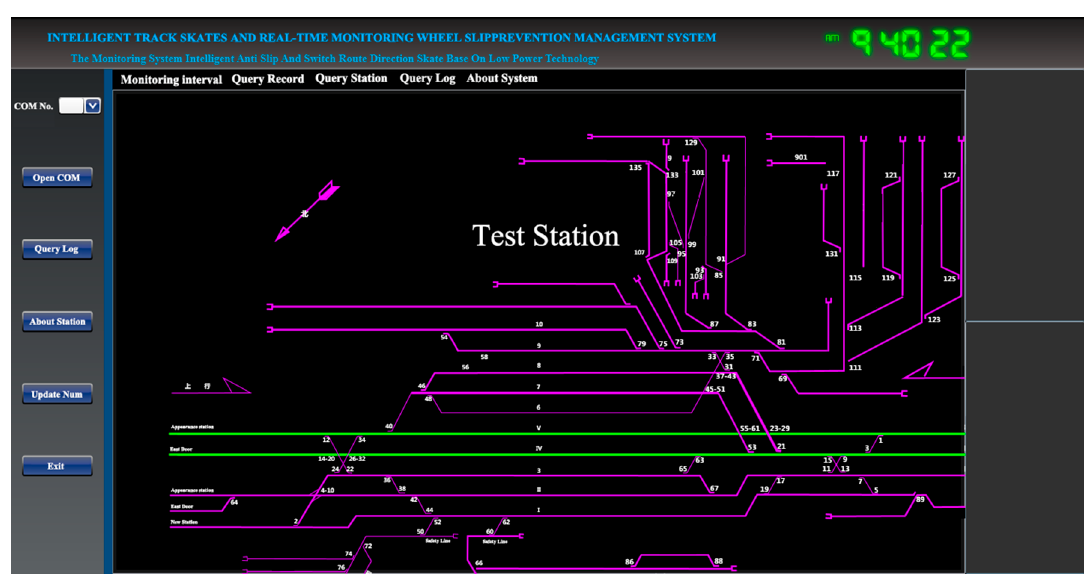
Figure 10. Monitoring interface.